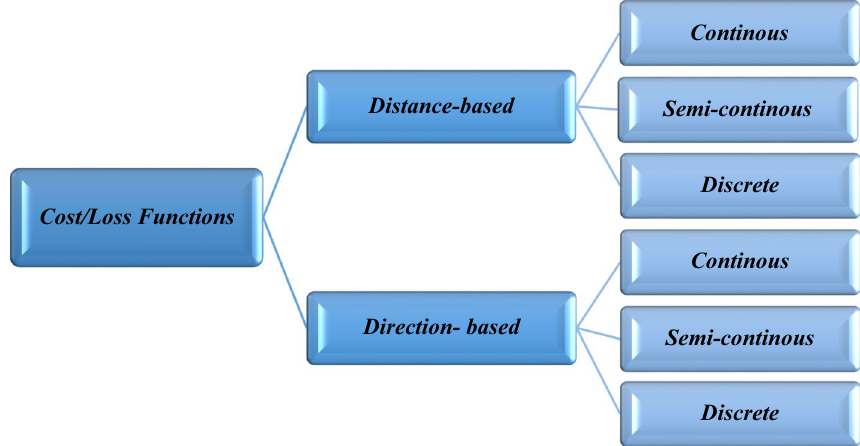
Fig. 1 Cost/loss functions clas- sification chart